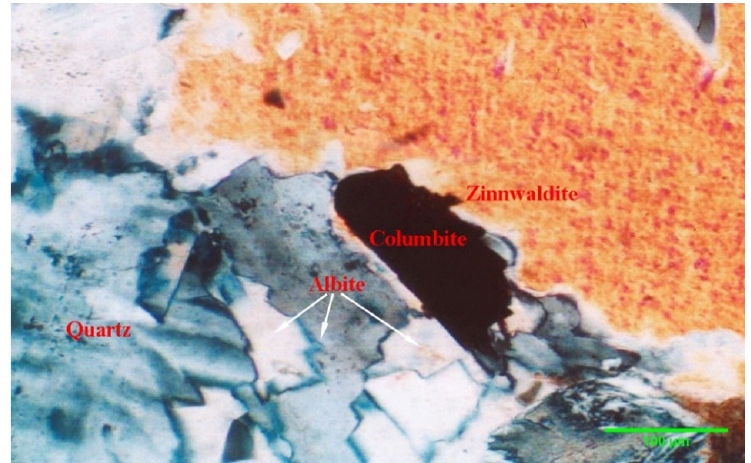
Figure 5. Columbite (dark red) is distributed between zinnwaldite (yellow interference color) and albite grain.